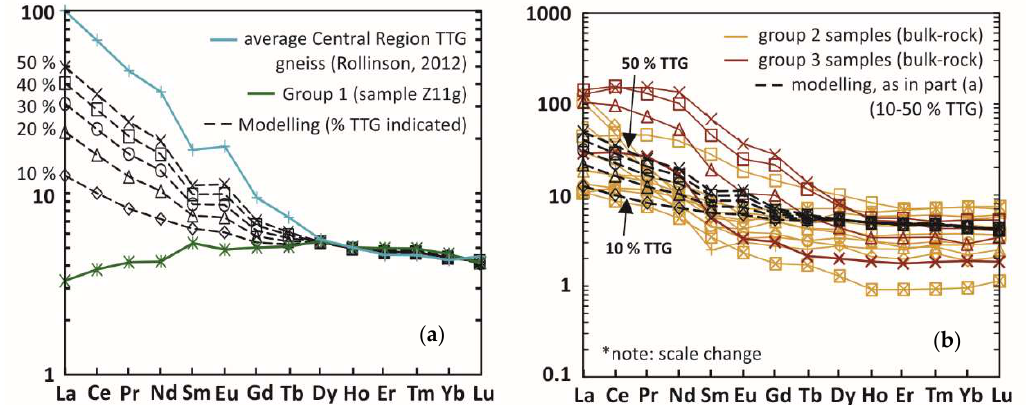
Figure 16. Chondrite-normalised [88] REE plots detailing the mixing calculations used to test the crustal contamination hypothesis. ( a ) modelling; ( b ) modelling and bulk-rock analyses of samples with high field strength-elements (HFSE) anomalies.